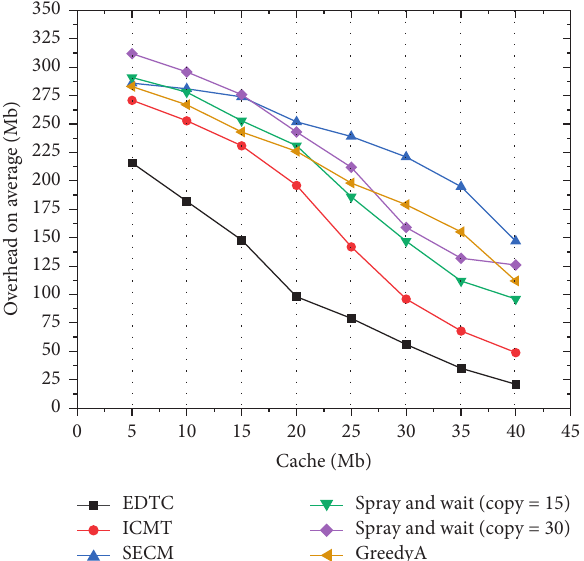
Figure 17: Relationship between overhead on average and cache.